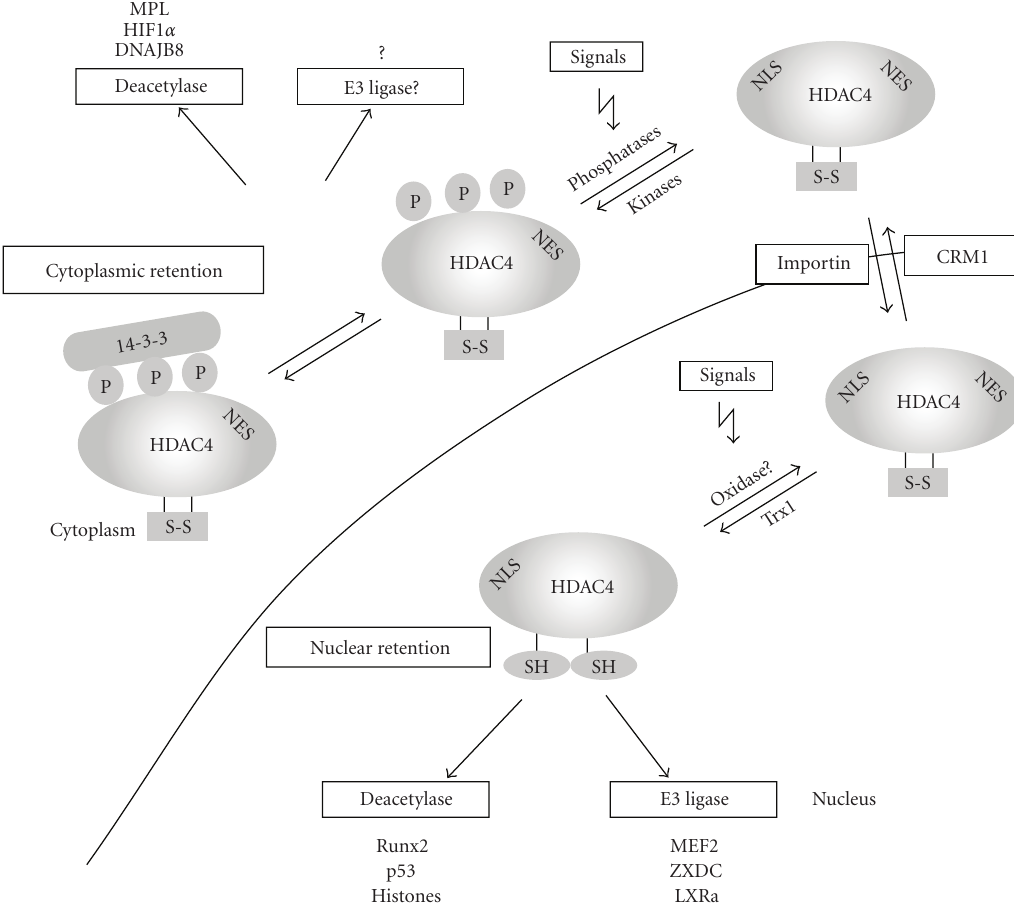
Figure 1: A model on the regulation of nucleo-cytoplasmic shuttling and the functions of HDAC4. HDAC4 dynamically shuttles between nucleus and cytoplasm, depending on its phosphorylation status. Phosphorylated HDAC4 binds to 14-3-3 and remains in the cytoplasm. The cytoplasmic form of HDAC4 might possess protein deacetylase activity. Whether cytoplasmic HDAC4 possesses SUMO E3 ligase activity remains unclear. Dephosphorylated HDAC4 is imported into the nucleus, where reduction of HDAC4 by Trx1 favors nuclear retention. Oxidases that catalyze the reverse reaction remain to be identified. Nuclear HDAC4 possesses deacetylase as well as SUMO E3 ligase activities on substrates indicated in the figure.